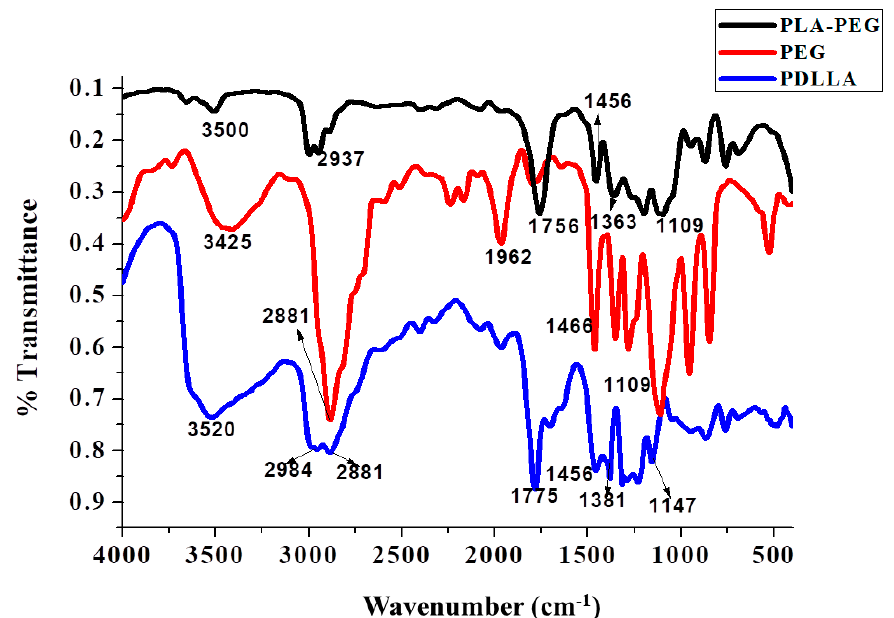
Figure 6. Overlay of the FTIR spectra of PLA-PEG copolymer (synthesized by acylation and esterifi- cation), PDLLA, and